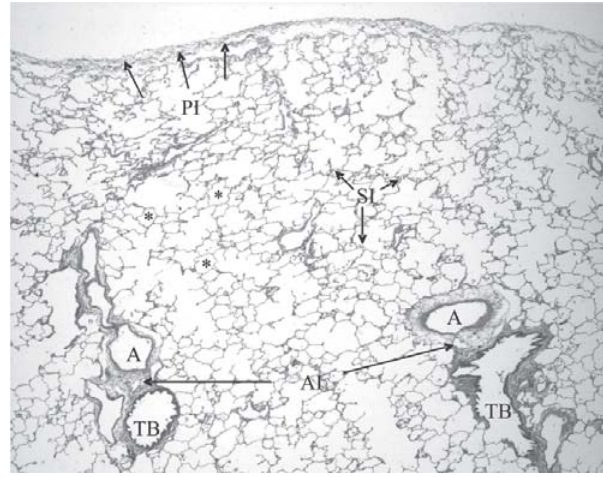
Figure 1 - (HE, 25X): Normal lung histology showing the 4 compartments studied: interstitium, alveolar spaces, airways and vessels. “PI”: peripheral interstitium; “SI”: septal interstitium; “AI”: axial interstitium; “*”: alveolar spaces; “TB”: terminal bronchioles; “A”: pre-acinar arterioles